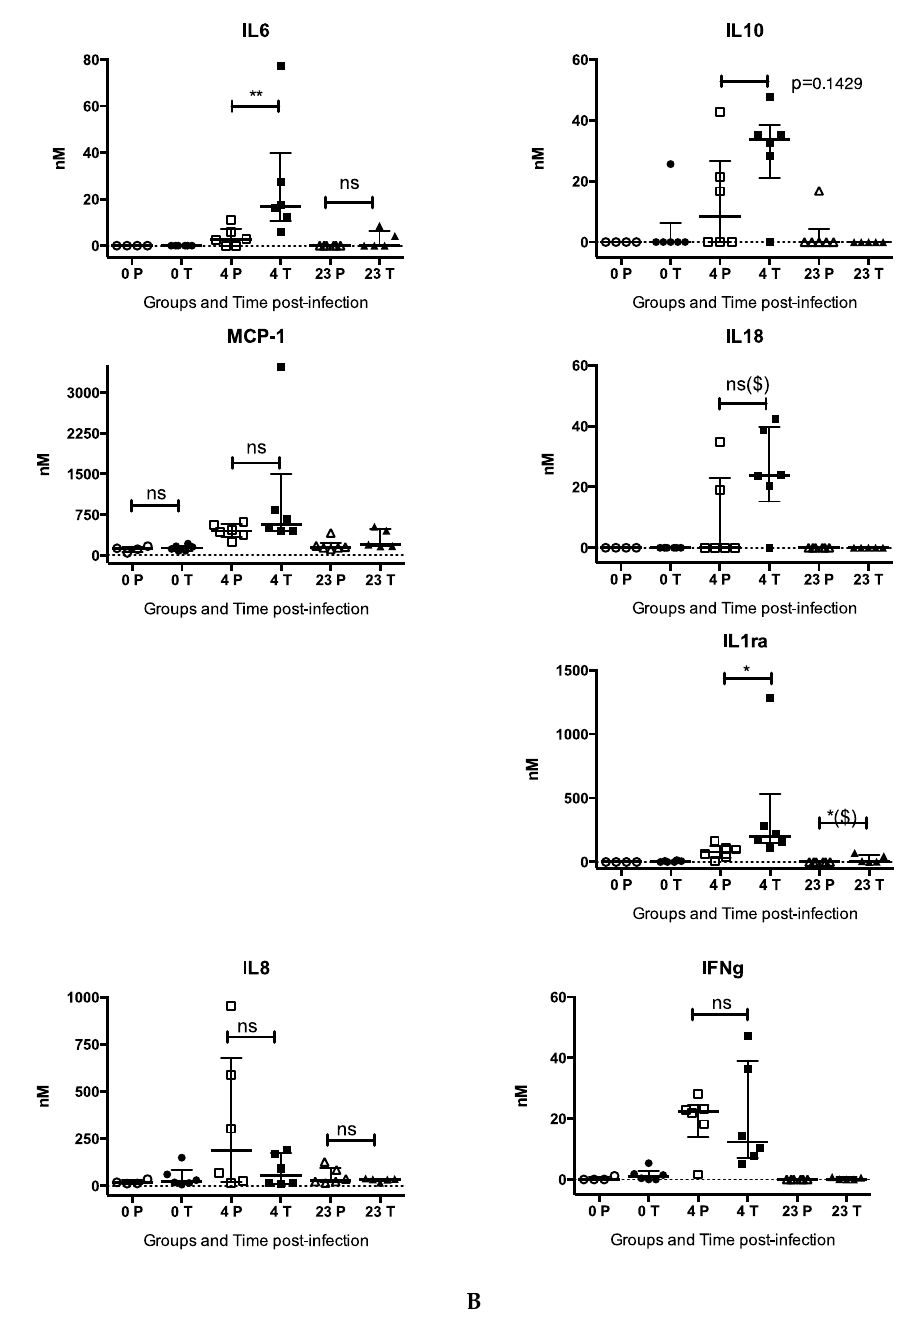
Figure 4. Evaluation of plasma inflammatory mediators in chloroquine treated (T, black symbols) versus non-treated (Placebo, P, open symbols) animals before infection (0P, 0T), and at 4, 23 days post-infection. Macaques were treated with chloroquine five days, and then were inoculated with 100 AID50 of CHIKV (day 0). Plasma grow-factor, cytokines and chemokines induced by the CHIKV infection were assayed using Luminex assays at day 0 before infection, four days post infection, and at day 23 post-infection thus 13 days after resolution of chloroquine treatment (see material and methods). ( A ) Chloroquine treatment induced variation in the expressed cytokines and chemokines: GM-CSF, IL-15, G-CSF, IL-12/23 (p40), and VEGF. Kruskal-Wallis then M&W test, ** p < 0.01, ns: not significant; ( B ) Cytokines significantly increased after infection (all p < 0.001: IL-6, MCP-1, IL-8, IL-10, IL-18, IL-1RA, IFN γ ; in chloroquine treated (dark symbols) versus non-treated (open symbols) animals. Comparison between groups: Kruskal-Wallis then M&W test, ** p < 0.01, * p < 0.05; $ p < 0.07, ns: not